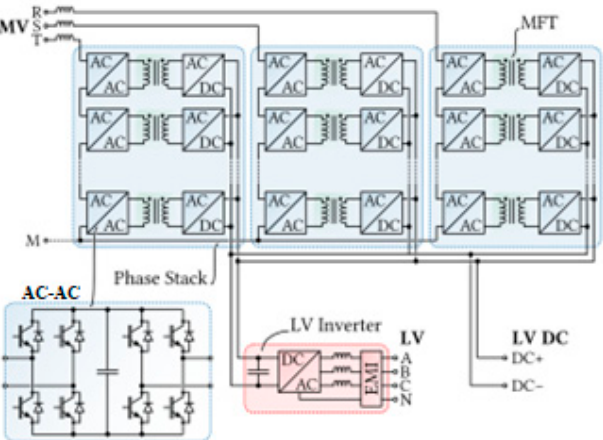
Figure 15. Typical topology of an MV/LV SST employing a cascaded converter structure on the MV side to handle the high voltage levels. Note that the AC–AC stages at the cascaded cells’ MV sides can feature a local DC link (AC–DC–AC-structure as shown in the figure) or be of a matrix-type (direct AC–AC conversion).